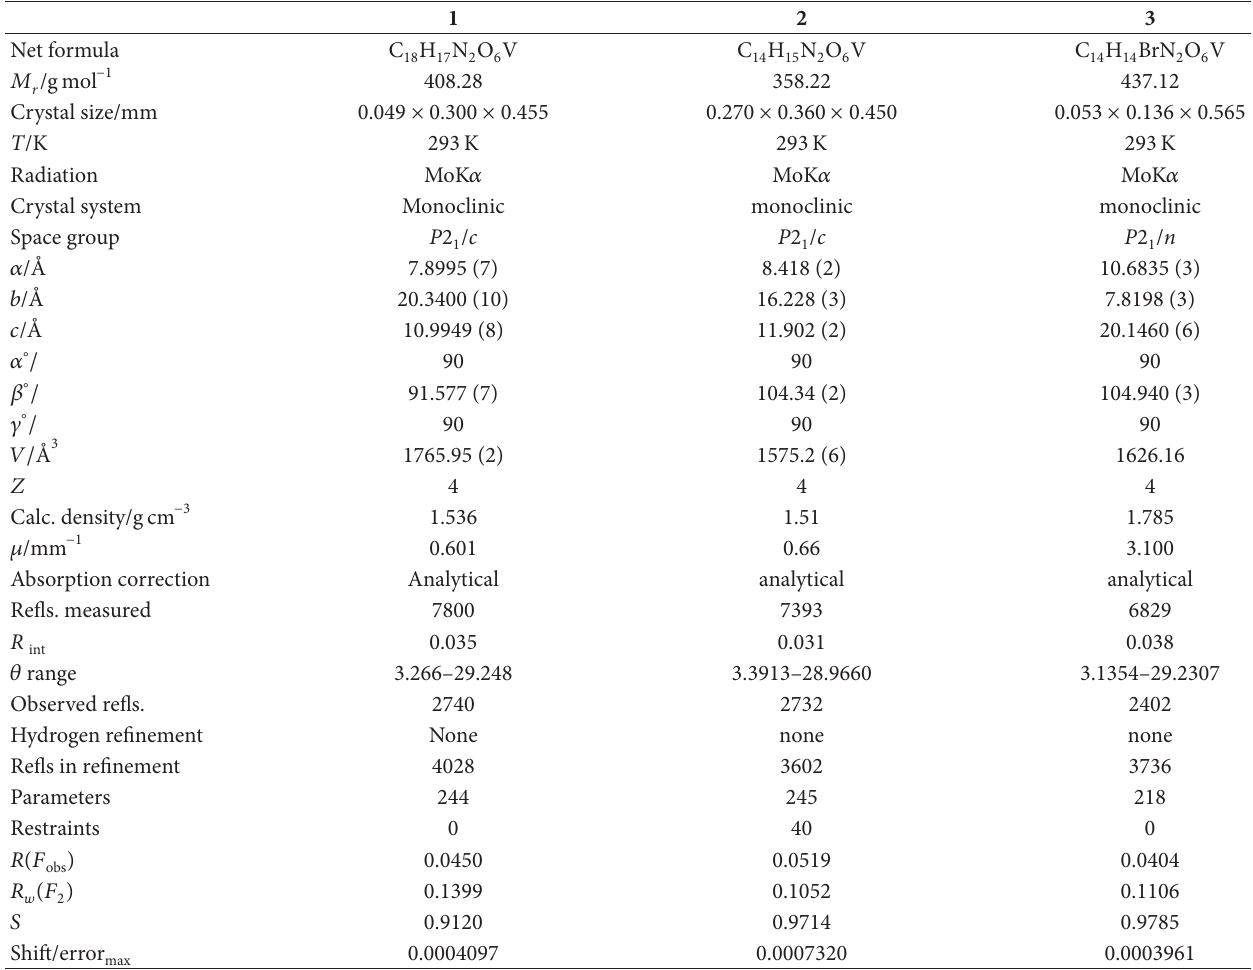
T 1: Crystallographic data of 1 , 2 and 3